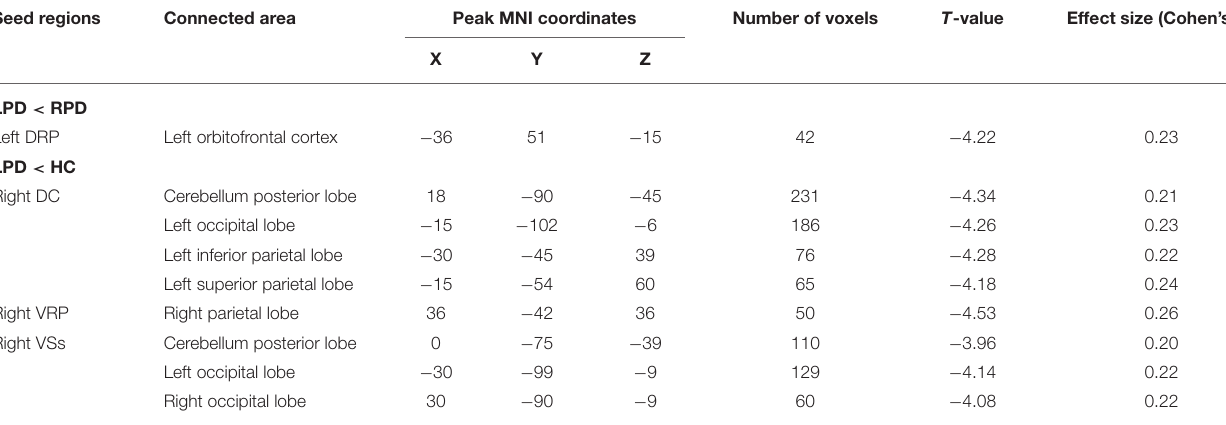
TABLE 3 | Differences in FC among PD patients and controls. Seed